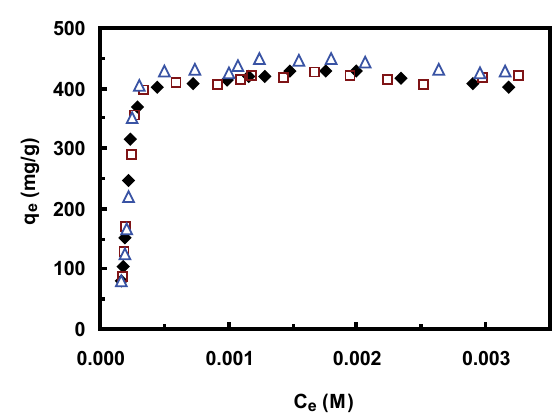
Figure 2. Adsorption isotherms of TX-100 on silica gel from aqueous solutions at ♦ 308, □ 318 and ∆ 328 K.